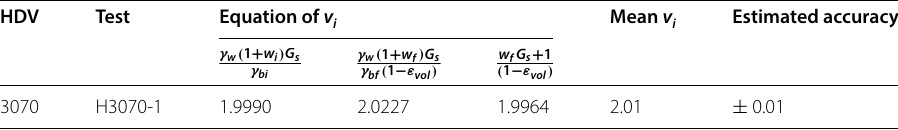
Table 4 Typical example of calculation of initial specific volume